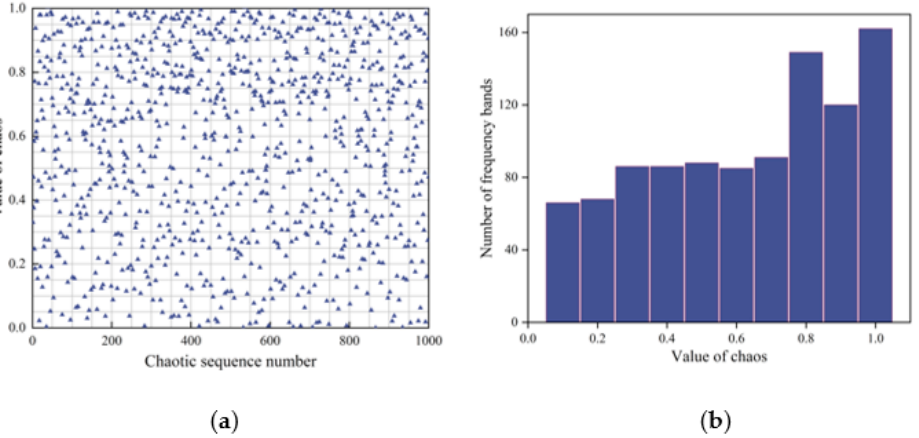
Figure 3. Comparison of chaotic values and random values of Hénon mapping: ( a ) scatter plot of chaotic value dimension distribution and ( b ) chaotic value frequency histogram.